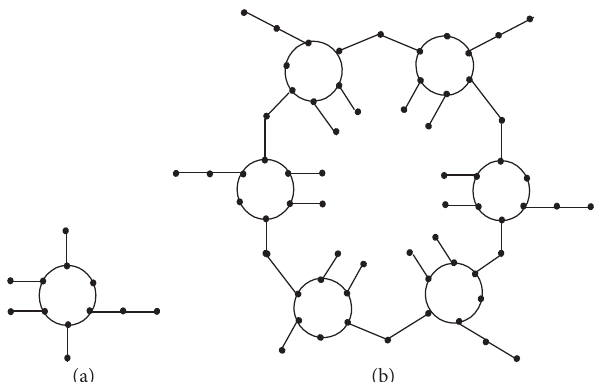
Figure 6: (a) Graph of blue starch-iodine for n � 1 and (b) graph of blue starch-iodine for n �